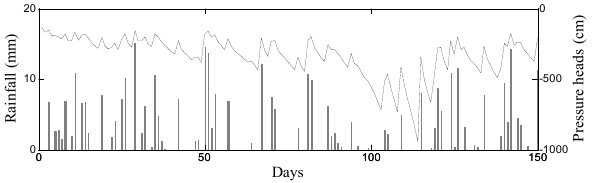
Figure 1. Rainfall pattern (bar plot) and synthetically generated “true” matric pressure head values at 5cm depth (solid